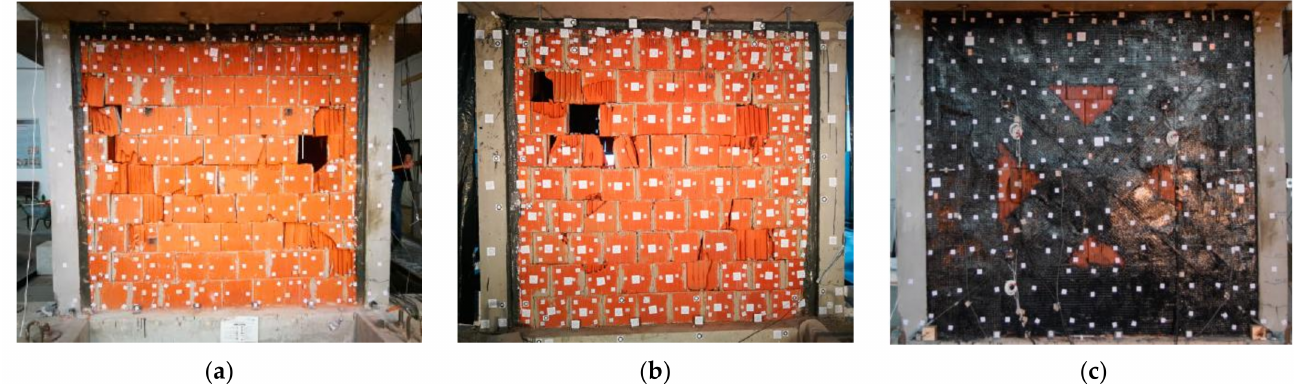
Figure 2. Structure significantly damaged after PHASE 1: ( a ) north side—type B infill; ( b ) south side—type B infill; and ( c ) FRPU-strengthened infill of type B after PHASE